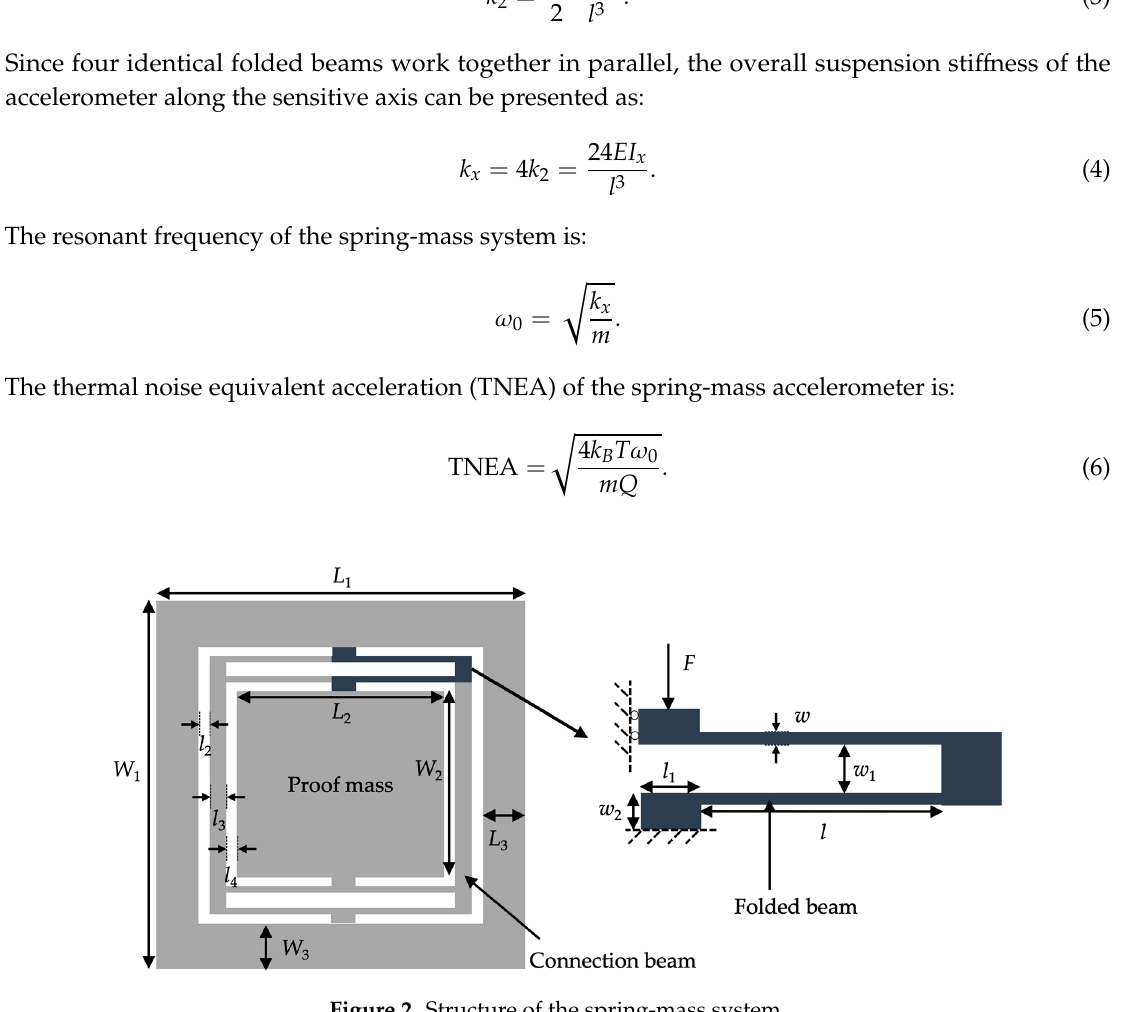
Figure 2. Structure of the spring-mass system.